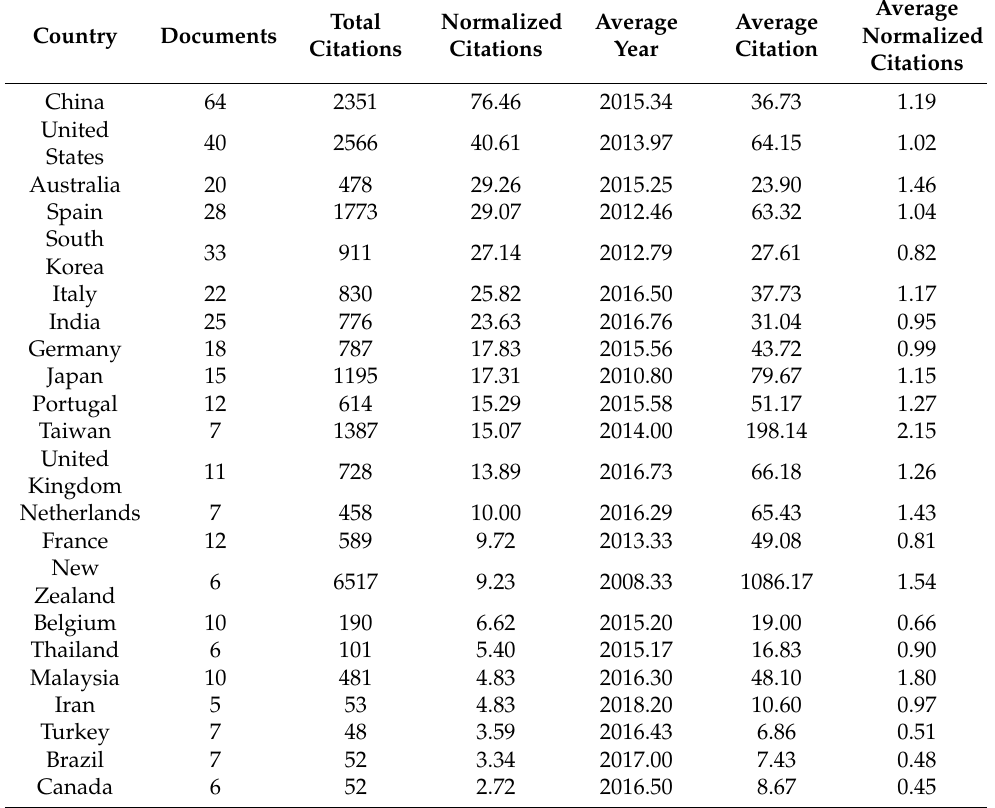
Table 3. Impact of countries with high article impacts based on normalized citations.